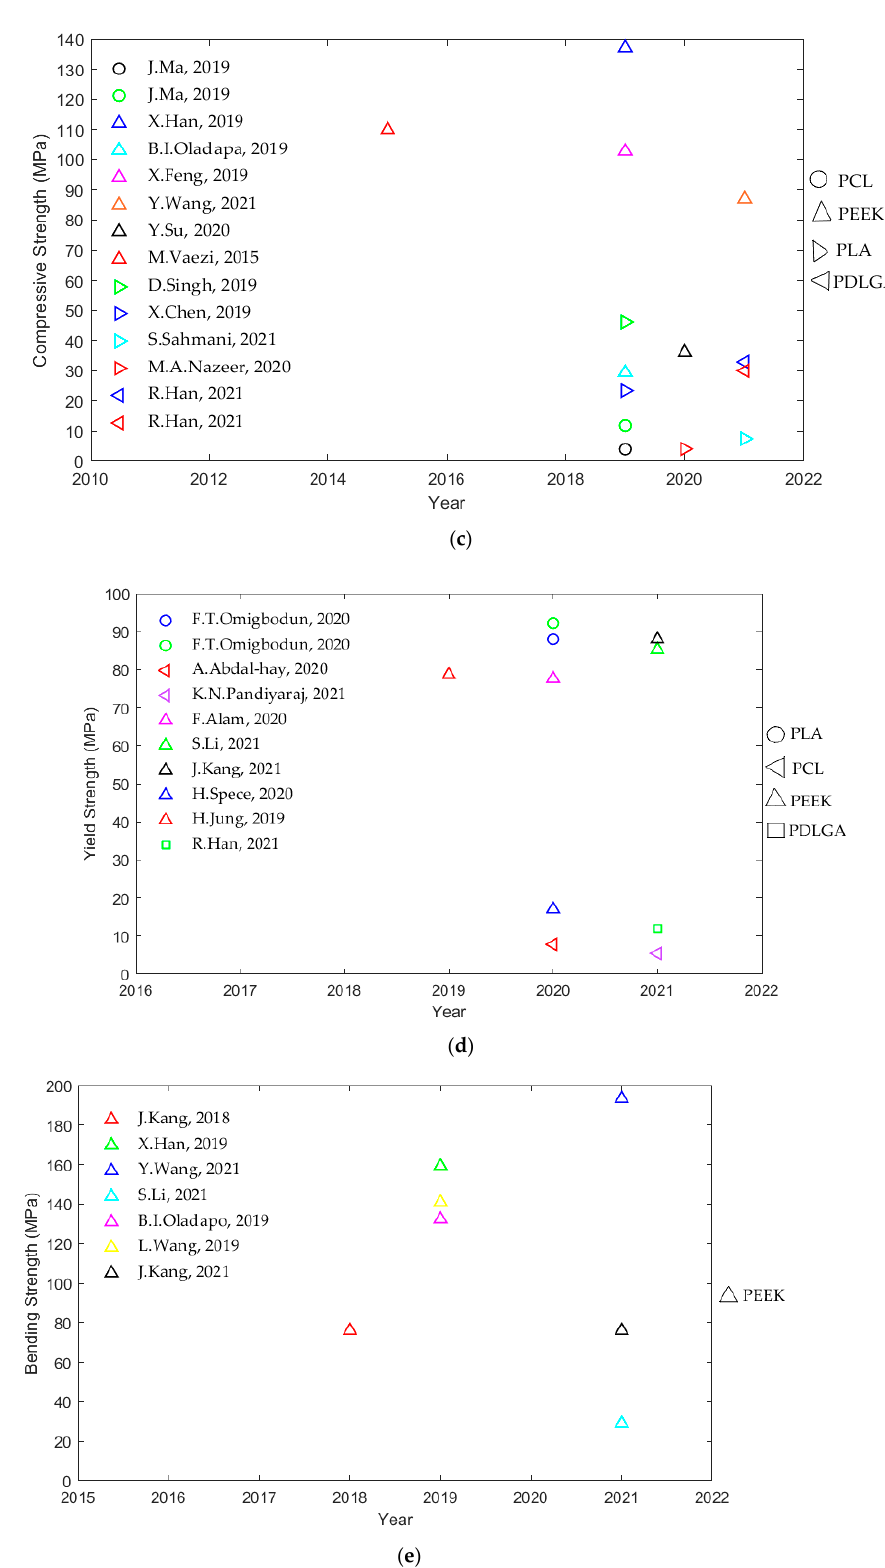
Figure 3. The combined values of mechanical properties for each polymer and composites recorded in the studies reviewed in this article vs. the year of publication. ( a ) Modulus of elasticity (GPa); ( b ) tensile strength (MPa); ( c ) compressive strength (MPa); ( d ) yield strength (MPa); ( e ) bending strength (MPa). (For interpretation of the references to color in this figure legend, the readers are referred to the web version of this article).